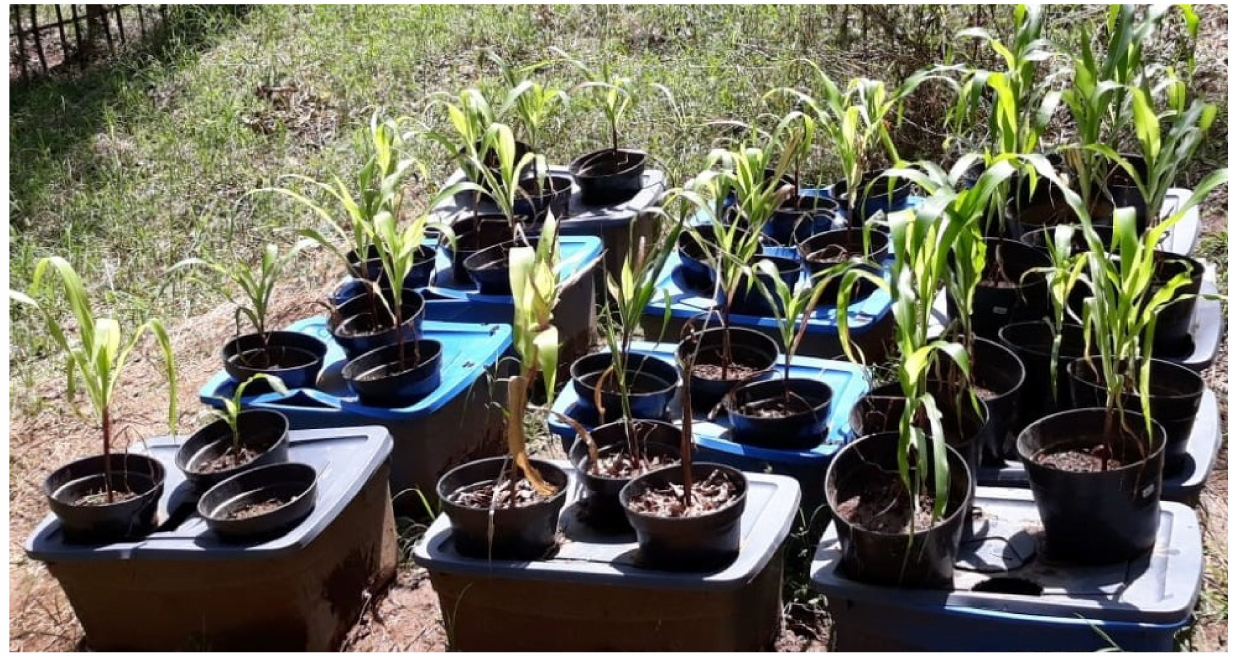
Figure 3. Maize plants from the first replica 40 days after having been planted according to the experimental